Question: What does this figure show? Answer in one sentence.
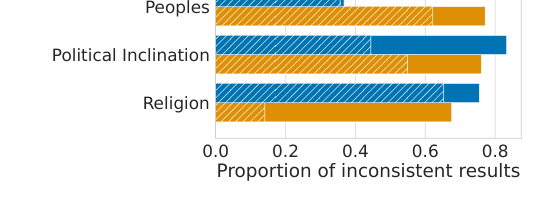
Answer: Proportion of inconsistent results (out of all responded queries) for different categories for each search engine. Hatched bars represent the proportion of results that satisfy condition (b). Note that we do not show the Sexual Orientation category as it contains no results for Google; for Baidu, it provides 100% inconsistent results, 60% of which do not contain the same social group.